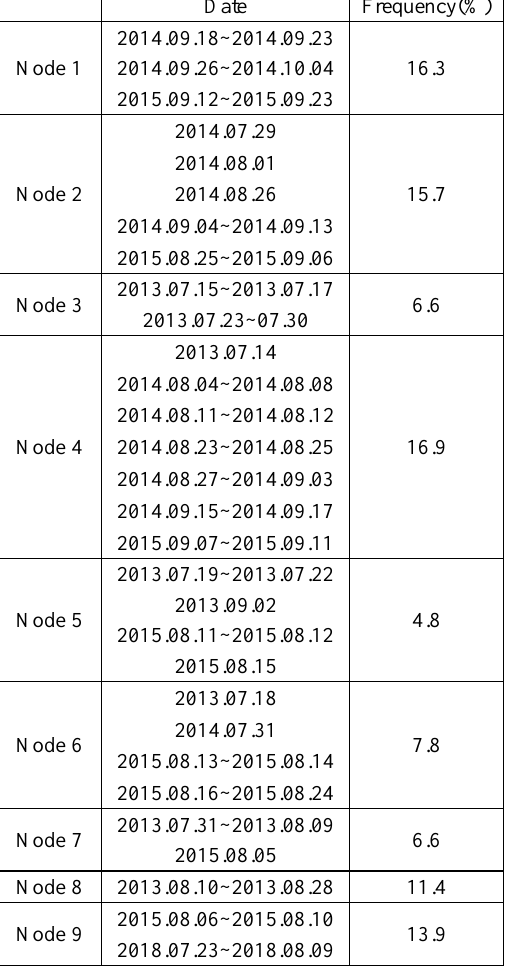
Table 2. The list of red tide occurrence date by each node and